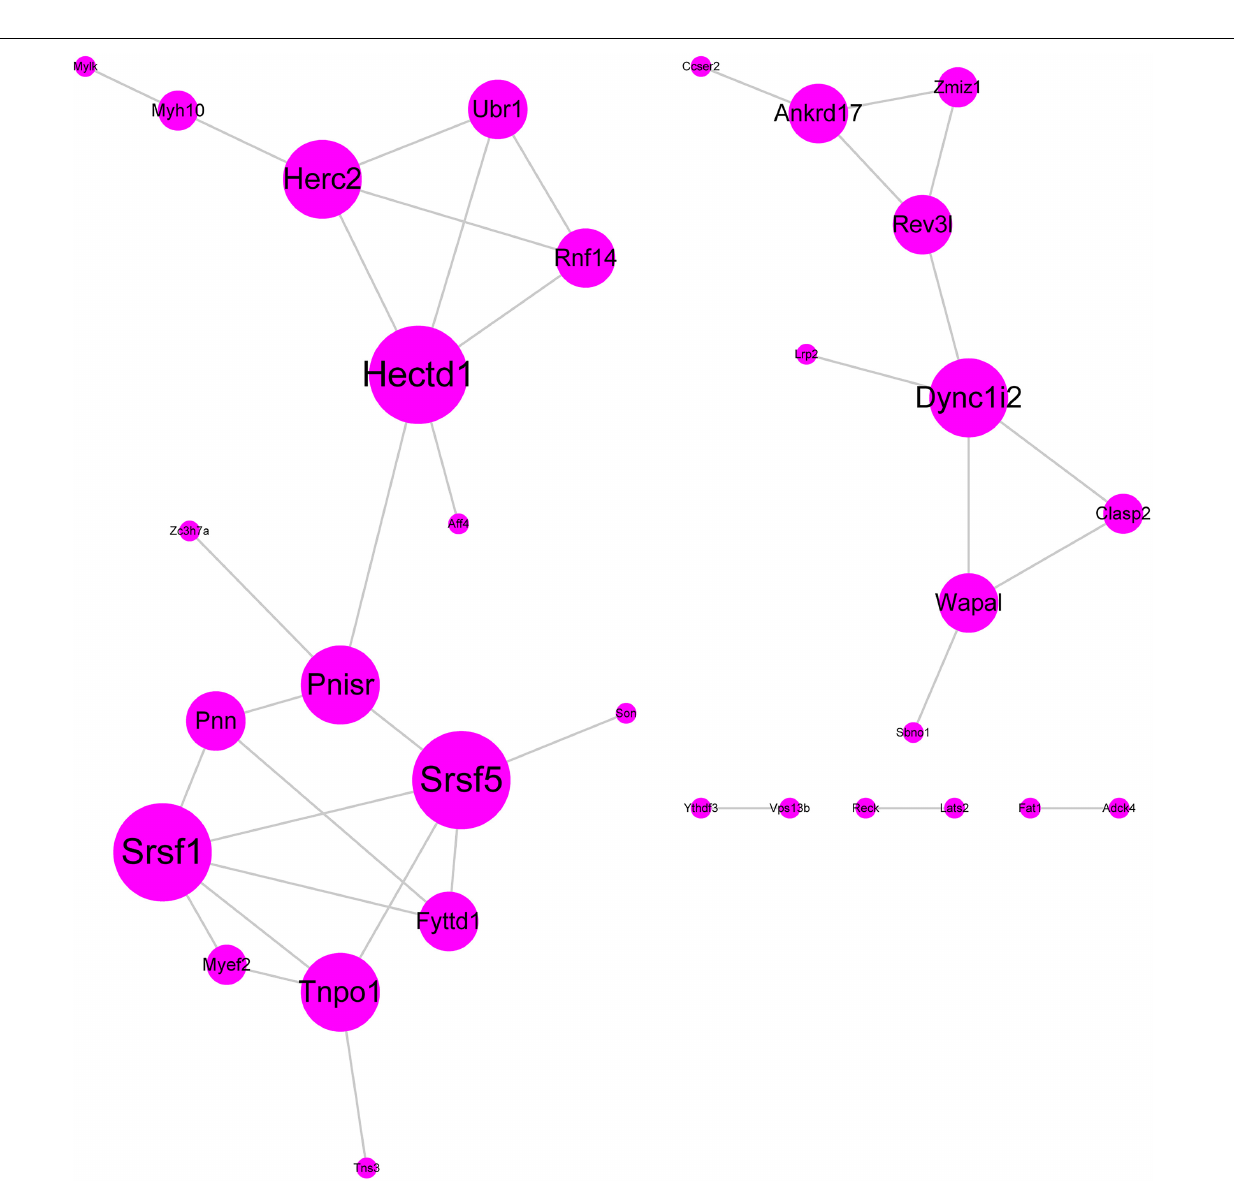
FIGURE 4 | Protein–protein interaction network. The color gradient and spot size represent the connectivity